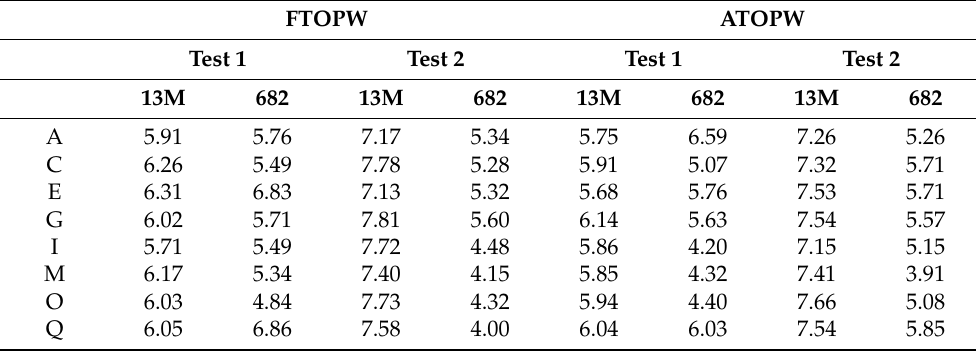
Figure 5. 3D plots for the interaction pH/temperature on phenol reduction (test 2: inoculum of B. pumilus followed 3 days after by C. boidinii ) in ATOPW (aged table olive processing water) ( A ) and FTOPW (fresh table olive processing water) ( B ) after 8 days. Test F and H of Table 3. Table 4 shows the viable count of B. pumilus and C. boidinii after 8 days. In test 2, B. pumilus attained higher counts (7.16–7.58 log CFU/mL) due to the longer incubation period (8 days), while in test 1 the bacterium was at ca. 6 log CFU/mL. The viable counts of yeast were ca. 5 log CFU/mL with some exceptions to this generalized statement. Table 4. Viable count (log CFU/mL) of B. pumilus (13M) and C. boidinii (682) sequentially inoculated (test 1: inoculum of C. boidinii followed by B. pumilus ; test 2: inoculum of B. pumilus followed by C. boidinii ) in ATOPW and FTOPW. Inoculum, 6.20 log CFU/mL for B. pumilus and 6.15 log CFU/mL for C. boidinii . Data are the average of two